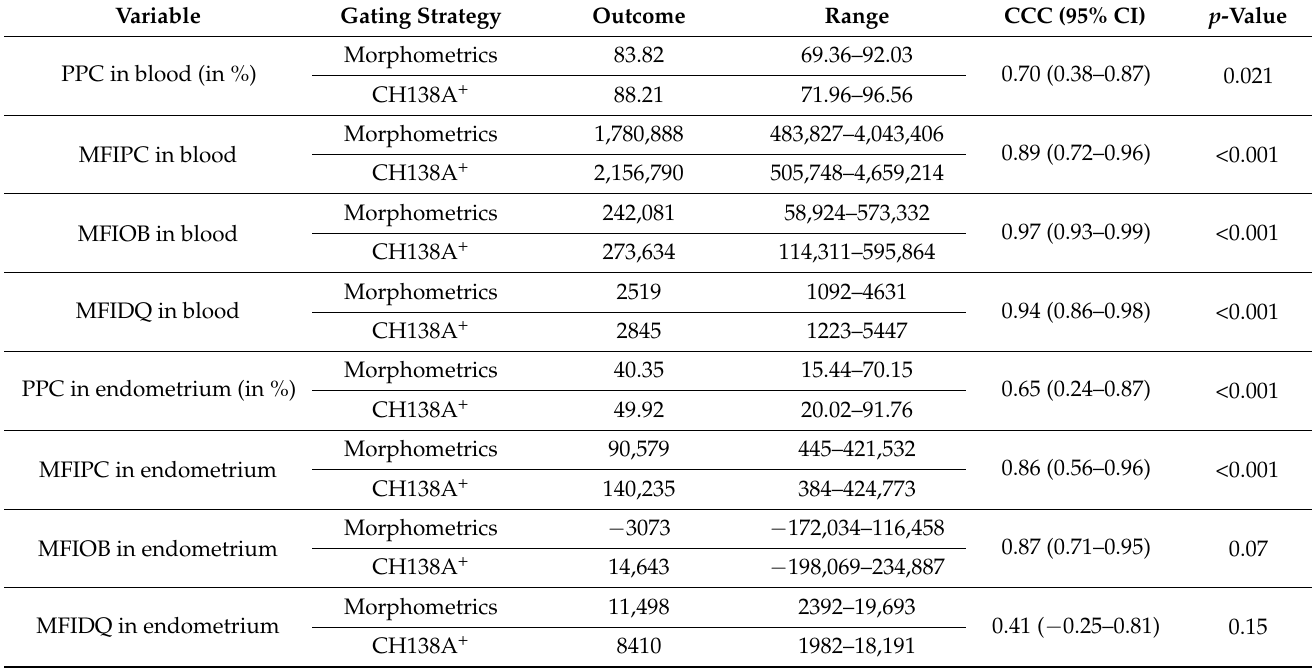
Table 2. Flow cytometric evaluation of polymorphonuclear leukocyte (PMN) functionality via oxidative burst (OB), phagocytosis (PC), and intracellular proteolytic degradation by DQ ovalbumin (DQ-ova) by CH138A immunolabeling or morphometrical characteristics. Blood and endometrial samples ( n = 11) were collected from Holstein-Friesian cows at 9–37 days in milk. All samples were CH138A immunolabeled (CH138A = specific bovine granulocyte marker) to identify PMN. The functionality outcomes of CH138A + events versus a gating strategy solely based on morphometrical characteristics (high FSC and high SSC) were compared intra-assay. The functionality outcomes included: percentage of PMN that performs PC (PPC, in %), median fluorescence intensity (MFI) of PMN that displayed OB (MFIOB), PC (MFIPC), or DQ-ova (MFIDQ) relative to the MFI of the respective autofluorescence control. Lin’s concordance correlation coefficient (CCC) and 95% confidence interval (CI) are reported with the p -value from the corresponding Pearson (parametric) or Spearman (non-parametric) test. Correlations were considered significant at p <